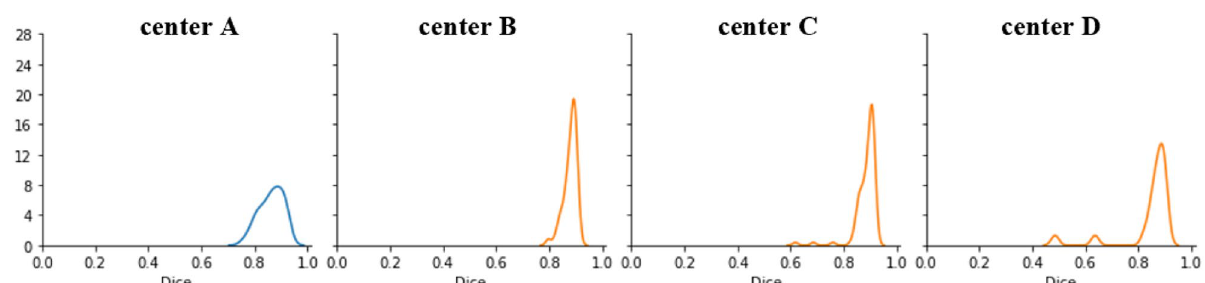
Figure 6. Distribution of DSC on the validation (blue curve) and the test dataset (orange curve). The distribution corresponding to Center C and D shows outliers (DSC < 0.7) which means less overlap between ground truth and predicted segmentation. The distribution also shows that the majority of the predictions have DSC between 0.8 to